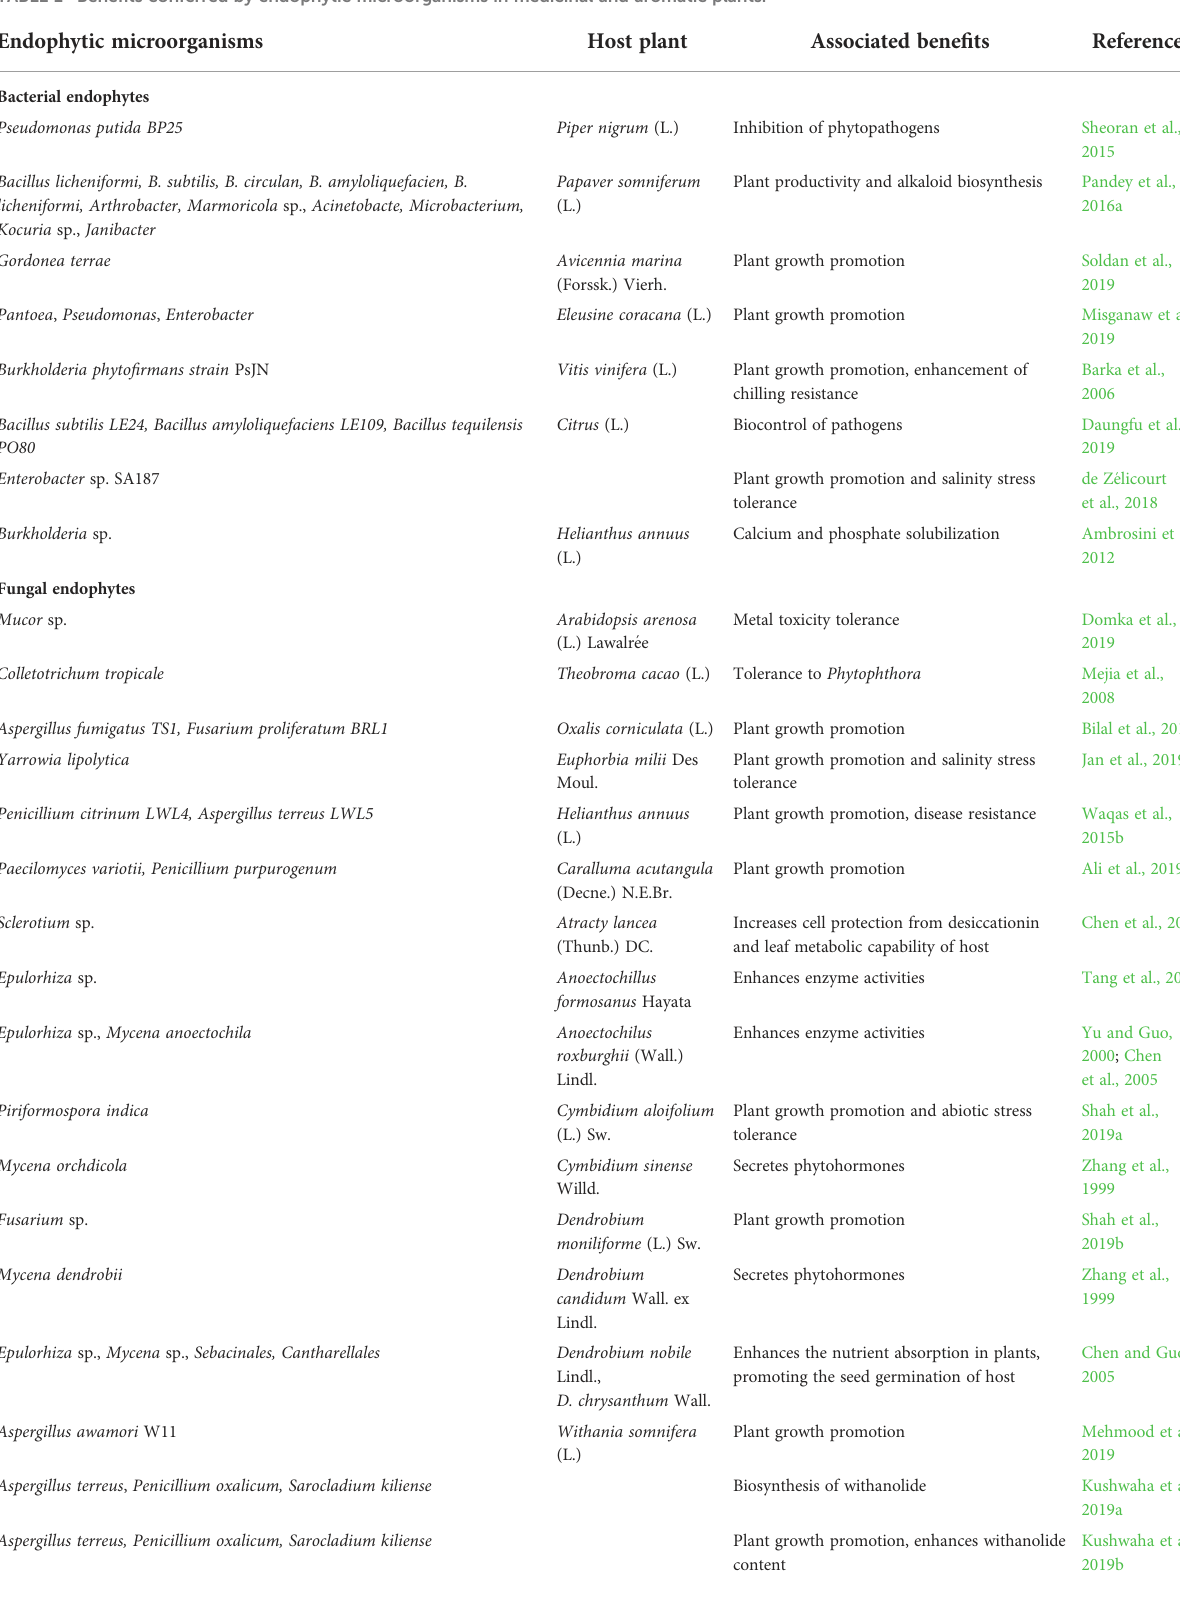
TABLE 1 Bene fi ts conferred by endophytic microorganisms in medicinal and aromatic